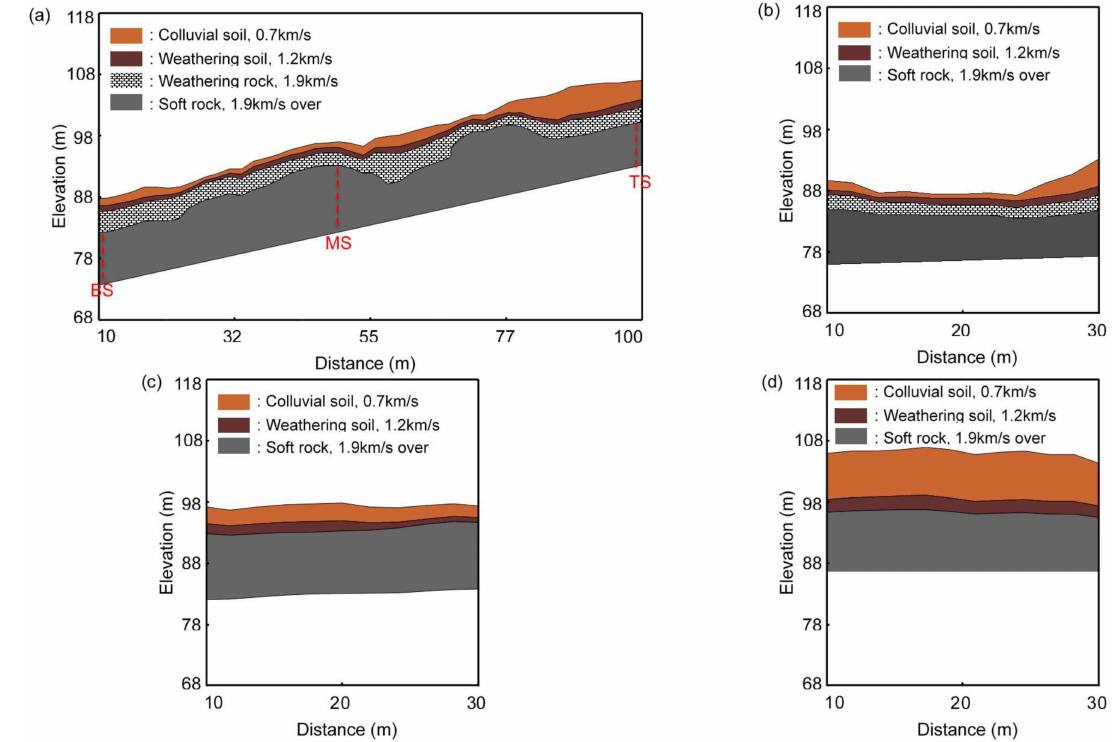
Figure 5. Converted primary wave velocity profiles: ( a ) BTS; ( b ) BS; ( c ) MS; and ( d )